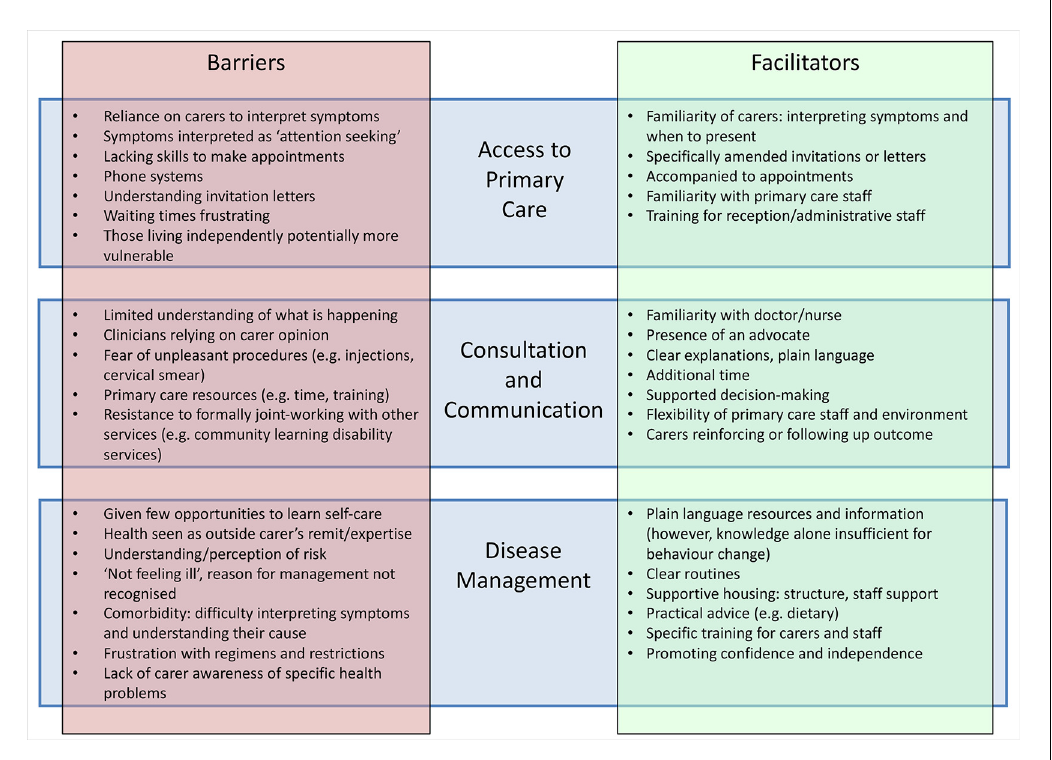
Figure 2. Barriers and facilitators to access and